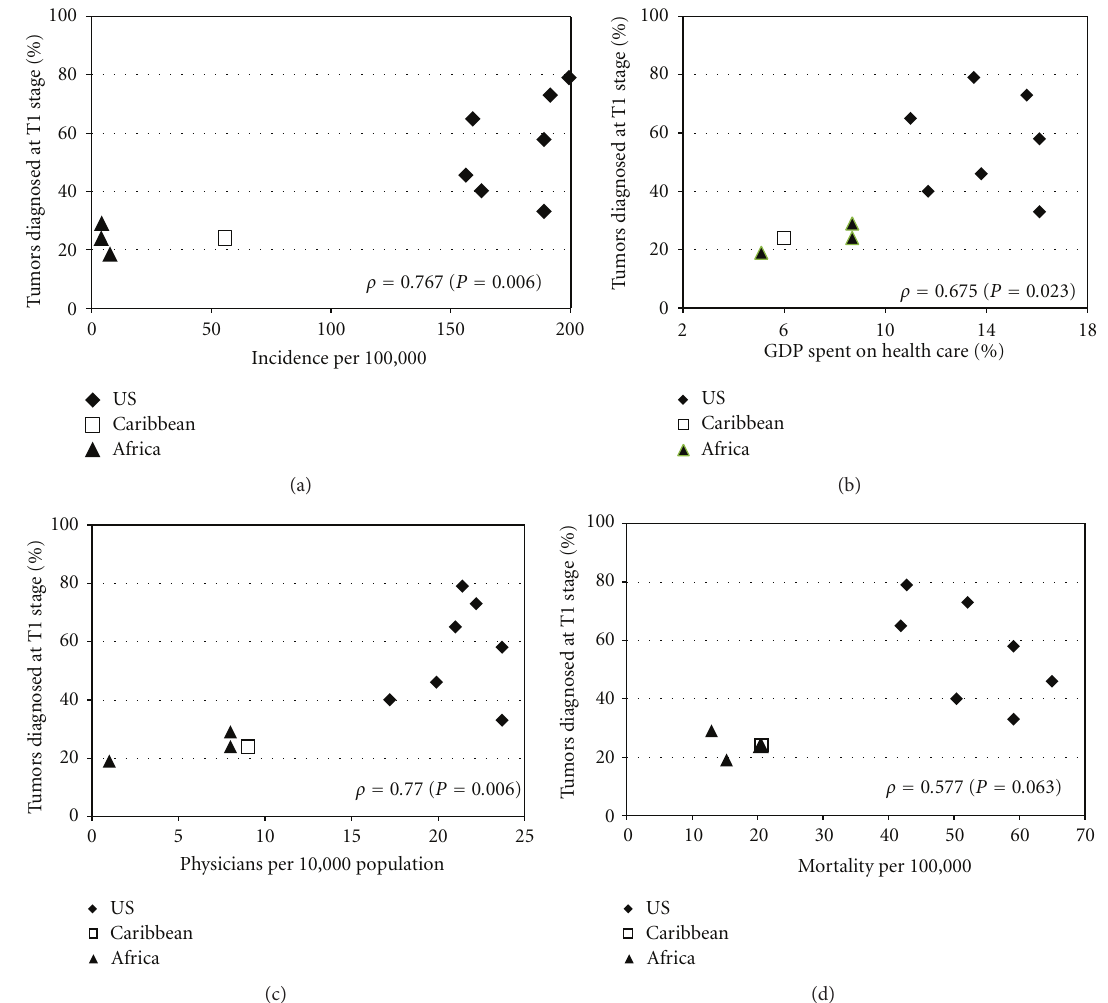
(c) Figure 3: Relationship of prostate tumor aggressiveness with CaP incidence, mortality, and health care-related statistics in men of African descent. % T1 stage tumor data from the MADCaP and AC3 Consortia. (a) Percent of tumors diagnosed at T1 stage by PCa incidence (per 100,000 population). Age-standardized incidence rates from 2008 GLOBOCAN and 2008 SEER-17 cancer registries (San Francisco-Oakland, San Jose/Monterey, and Los Angeles, California; Connecticut; Detroit; Louisiana; New Jersey). (b) Percent of tumors diagnosed at T1 stage by percent of gross domestic product spent on health Care. Sources of percent of gross domestic product spent on health care: (1) Outside USA: WHO World Health Statistics 2010 (http://www.who.int/whosis/whostat/EN WHS10 Full.pdf); (2) USA: Centers for Medicare and Medicaid Services (https://www.cms.gov) by state. (c) Percent of tumors diagnosed at T1 stage by number of physicians per 10,000 persons. Sources of data on physicians per 10,000 persons: (1) Outside USA: WHO World Health Statistics 2010 (http://www.who.int/whosis/whostat/EN WHS10 Full.pdf); (2) USA (by state): Dionne, M., Moore, J., Armstrong, D., Martiniano, R. (2006) The United States health workforce profile. Rensselaer, NY: Center for Health Workforce Studies, School of Public Health, SUNY Albany. (d) percent of tumors diagnosed at T1 stage by CaP mortality (per 100,000 population). Mortality data for 2006 from CDC Wonder Database